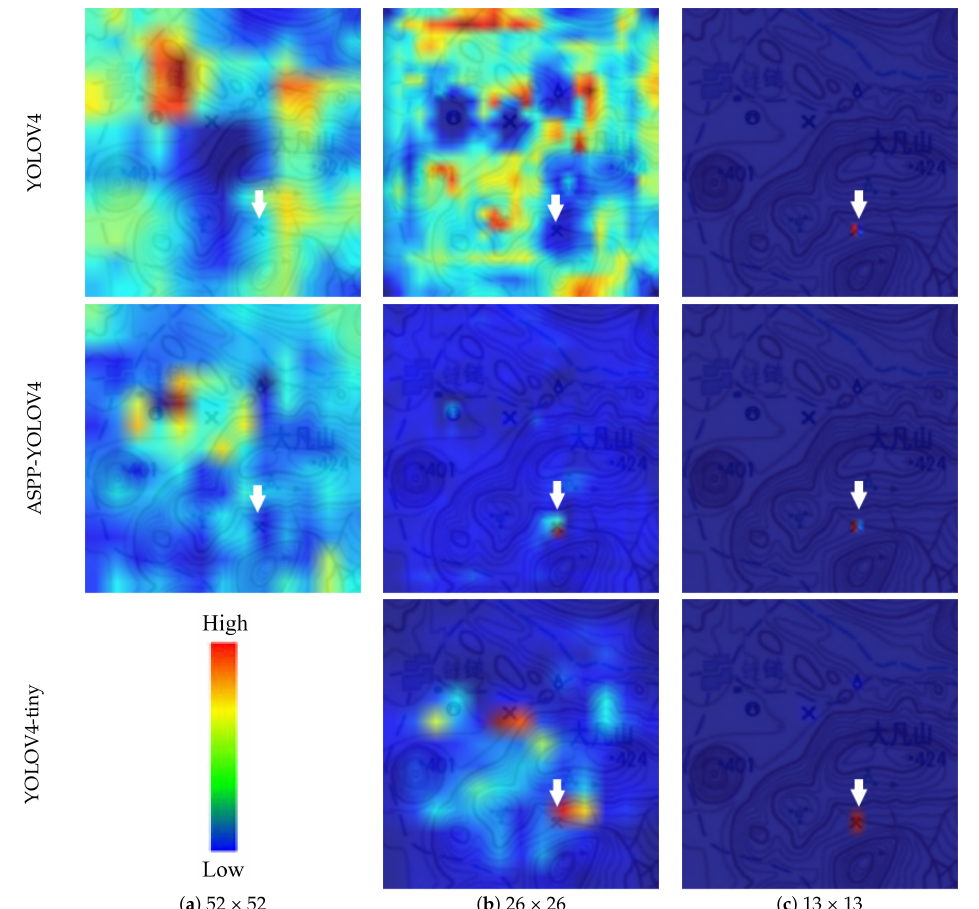
Figure 16. Comparison of Grad-CAM results obtained with YOLO heads of three YOLOv4-based models. Warmer colors indicate higher interest in the area, whereas cooler colors indicate the opposite; the white arrow points to the object of the study, the point symbol